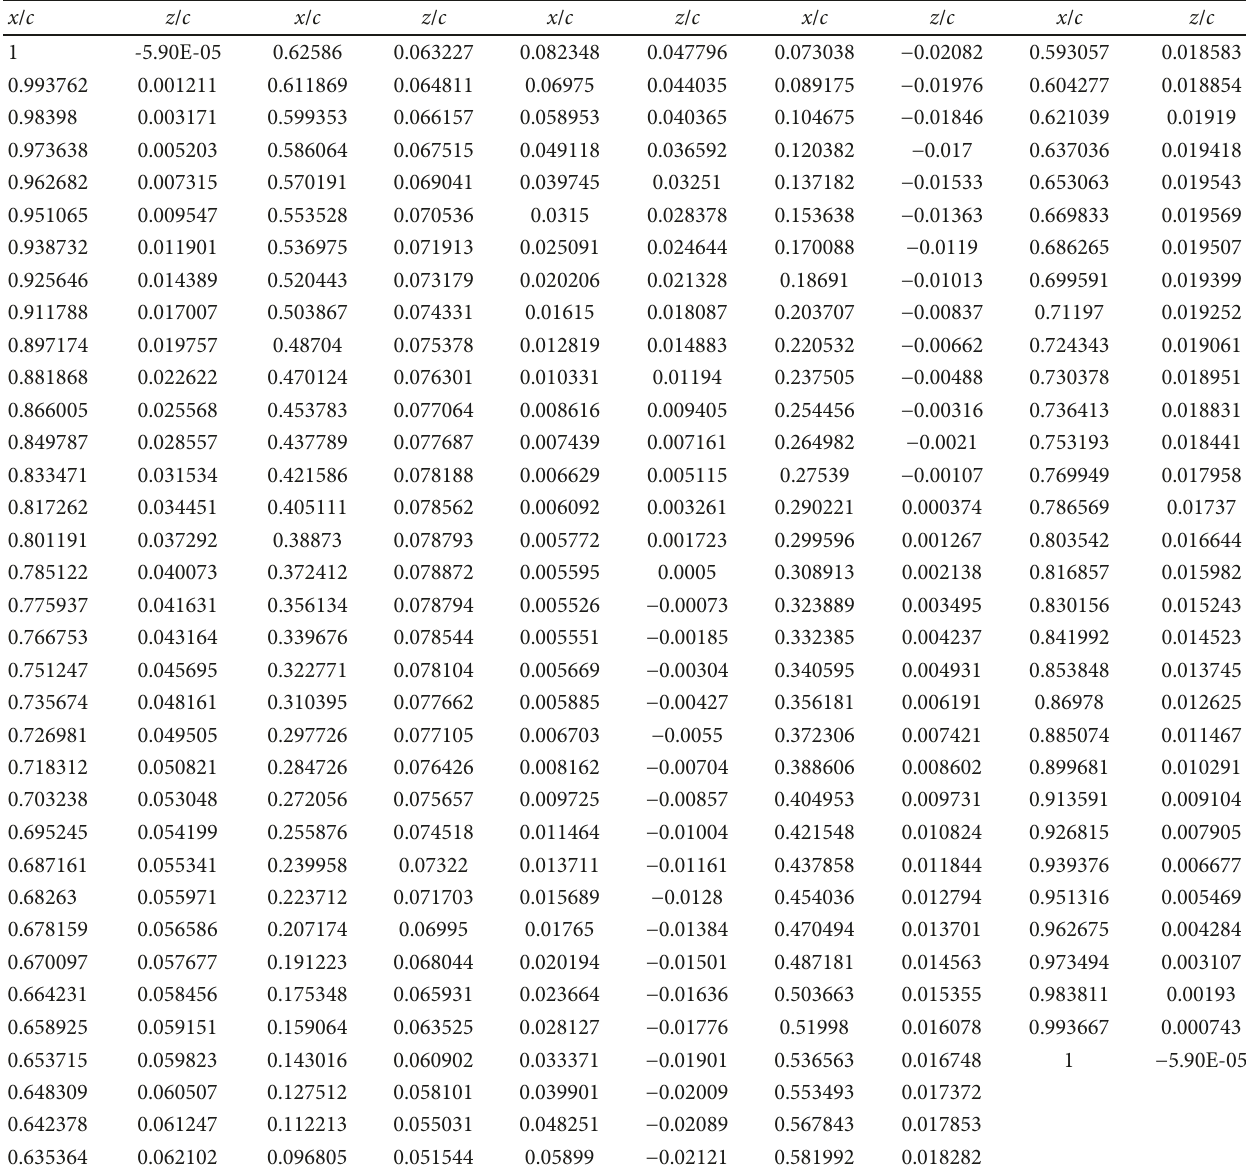
Table 1: Normalized coordinates of the cross-section of T-motor 18x6.1 at r /R